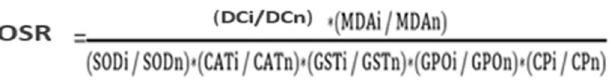
Figure 2. Formula for calculating OSR.